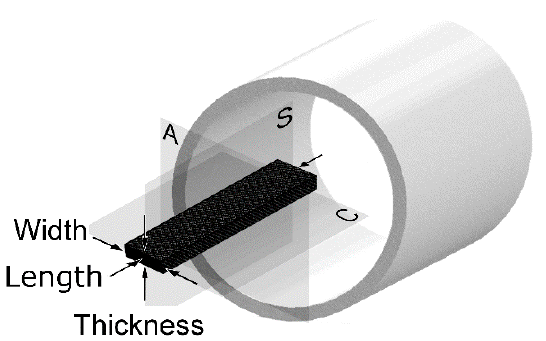
Figure 2. Magnetic resonance imaging (MRI) coordinate system comprising 3 mains view planes: Axial (A) or through-the-specimen length (l), Coronal (C) or through-the-specimen thickness (t), and Sagittal (S) or through-the-specimen width (w).